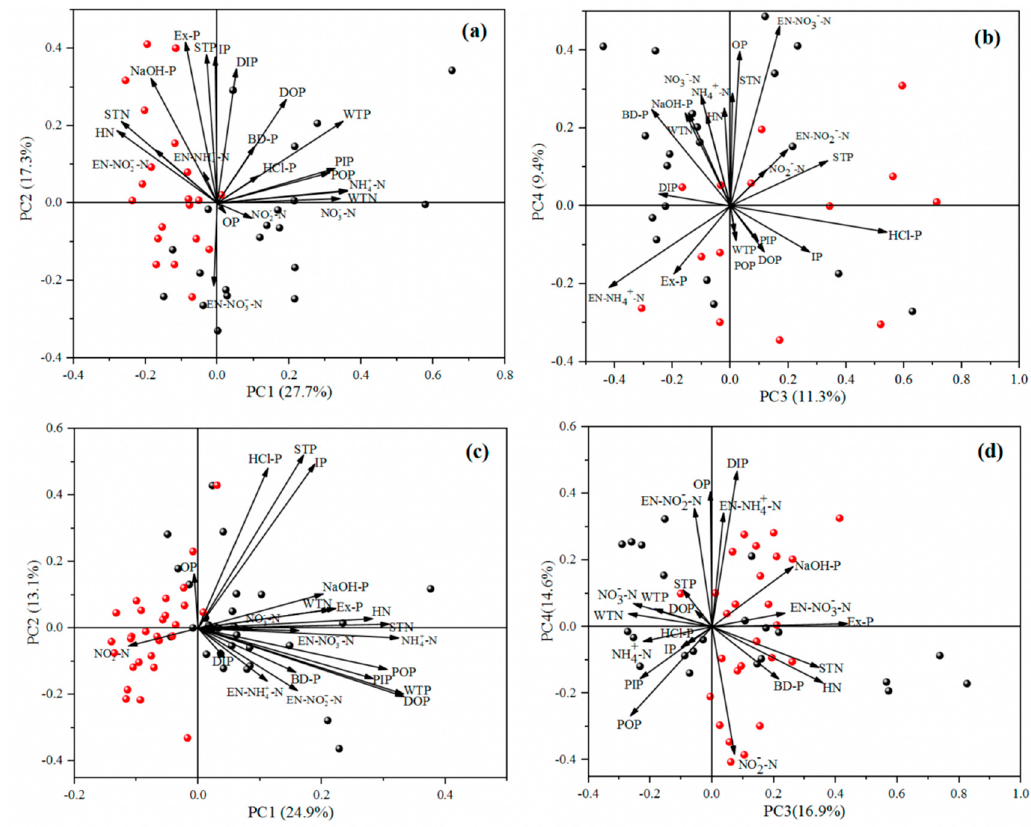
Figure 12. Plane scattered point load map of different N and P based on PCA. ( a , b ) show the four principal components extracted in Pi River, ( c , d ) show the four principal components extracted in Shiting River.